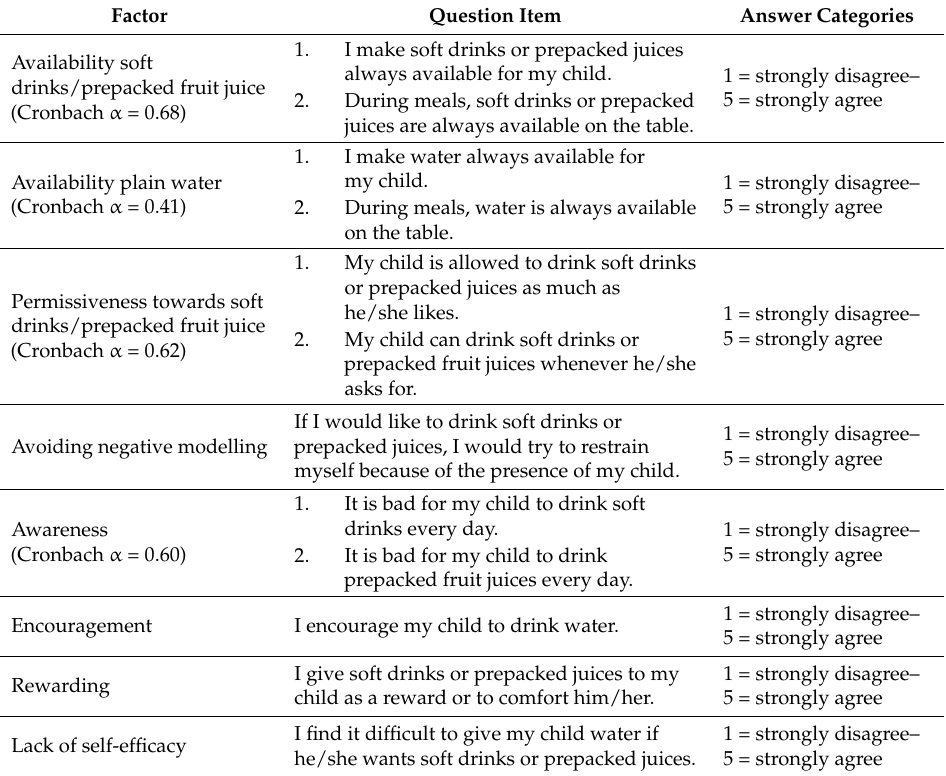
Table 1. Formulations of the questionnaire items and the psychometric